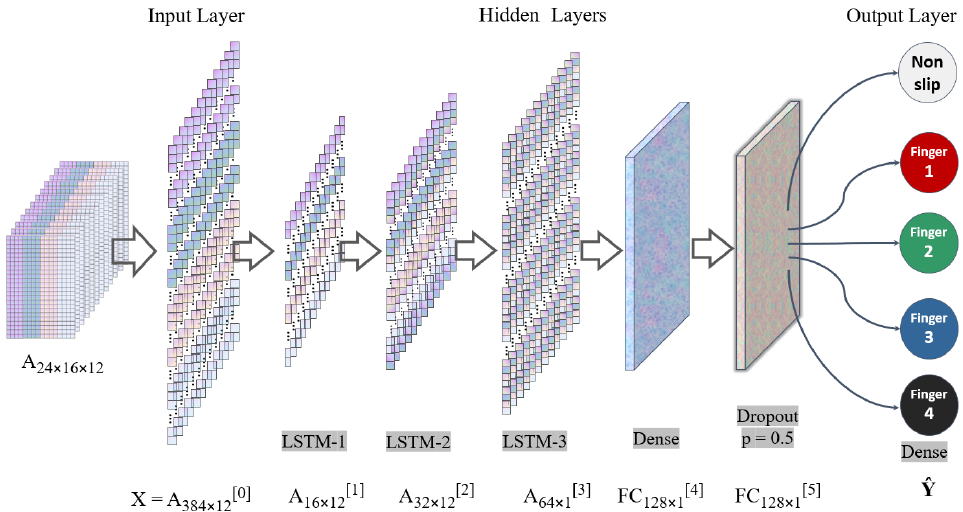
Figure 6. Proposed slip detection neural network architecture.